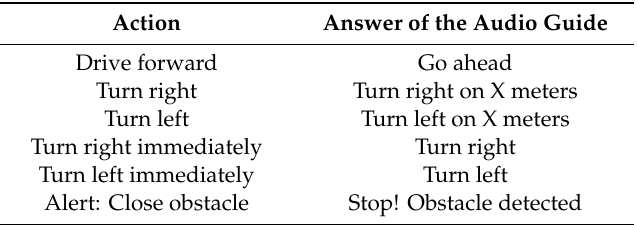
Table 2. Set of instructions for indoor navigation.